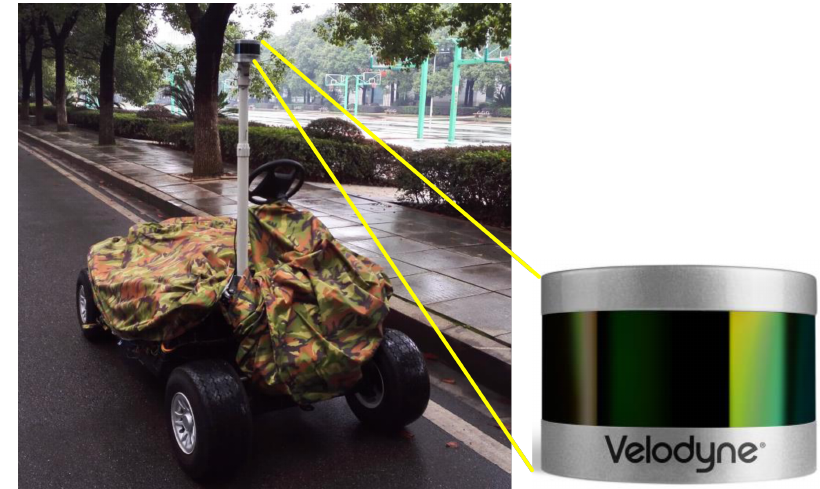
Figure 8. Our platform and lidar